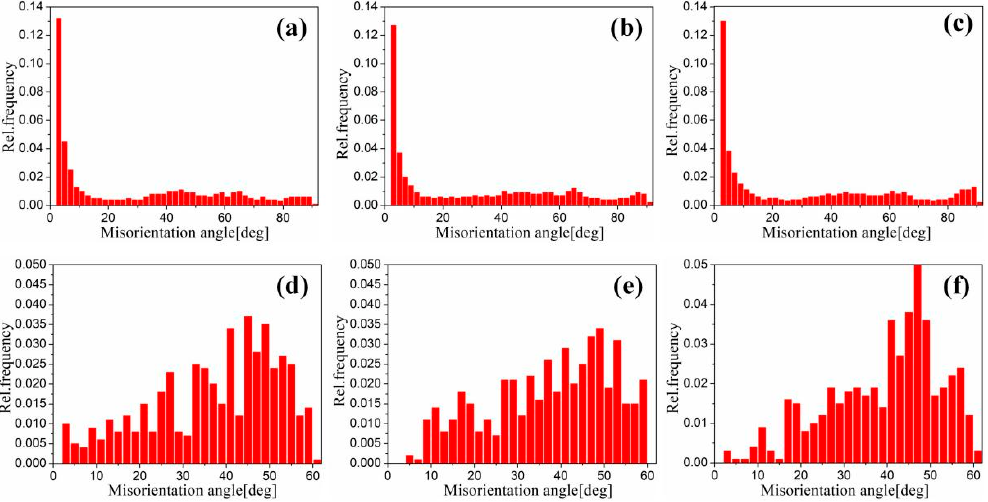
Figure 18. Misorientation distribution in different regions near the interface of specimen B3. ( a ) Ti-